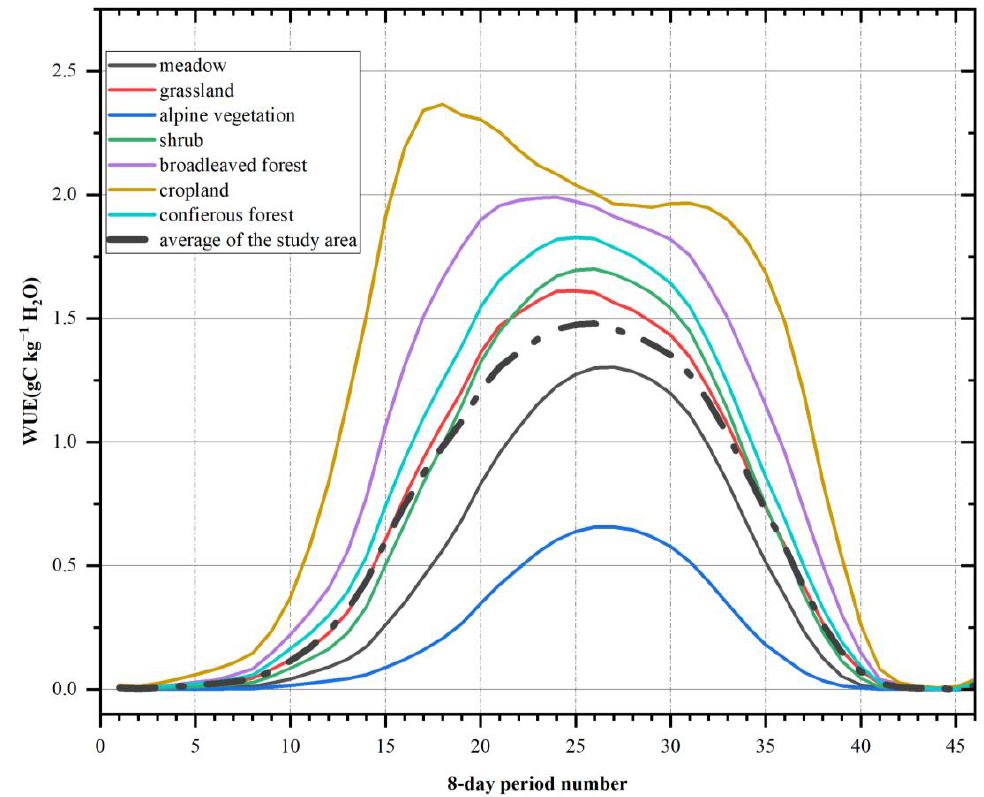
Figure 9. Intra-annual variation of WUE for different vegetation types.